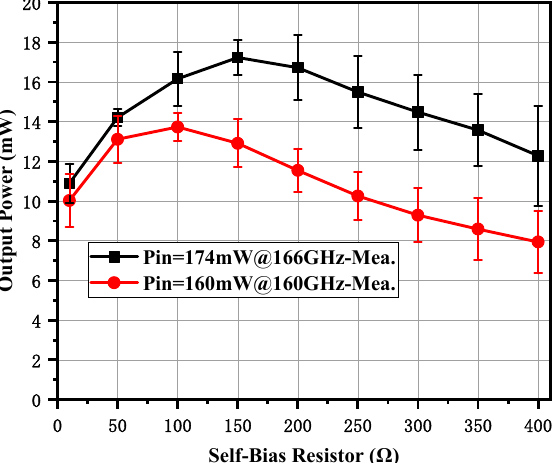
Figure 12. Measured output power of the doubler under different self-bias resistors with the maximum input power.